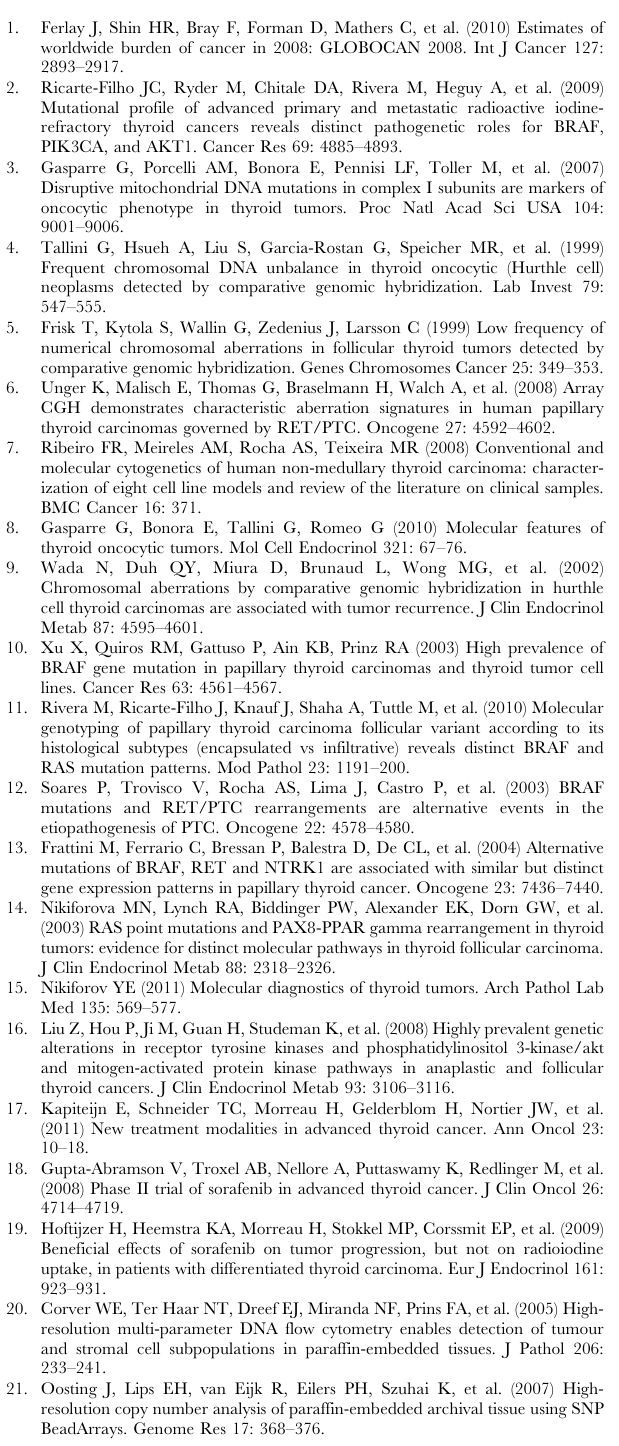
Figure S1 Examples of DNA content analysis of FFPE oncocytic follicular thyroid carcinomas by McLeod et al.